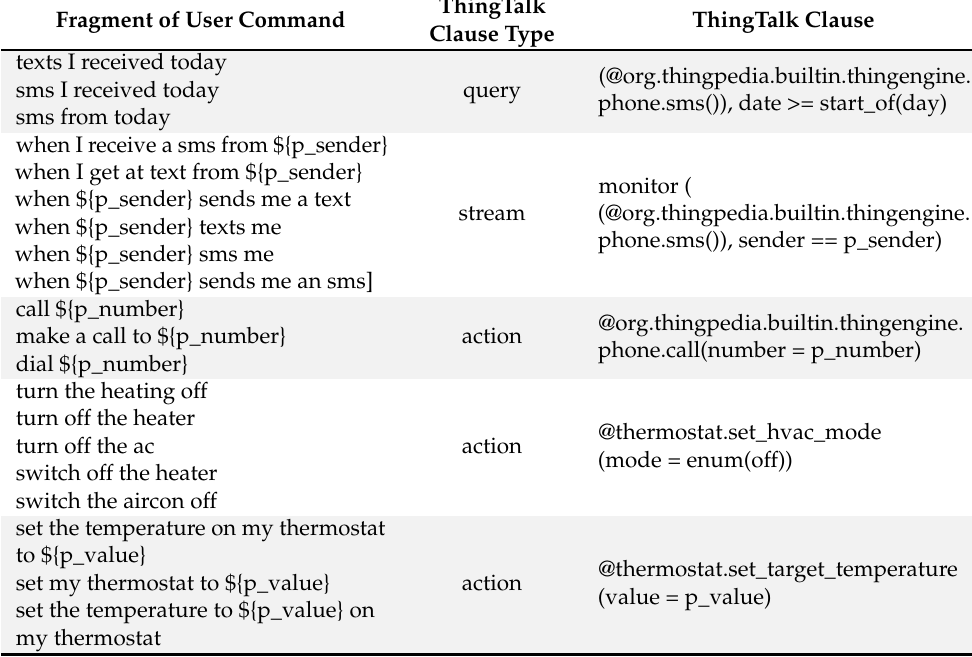
Table 2. ThingTalk clause